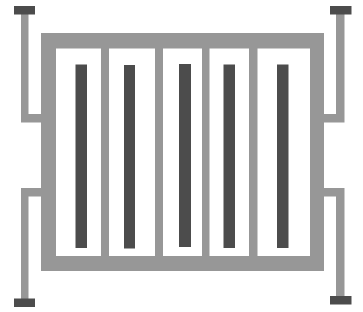
Figure 14. Proposed electrostatic MEMS converter.